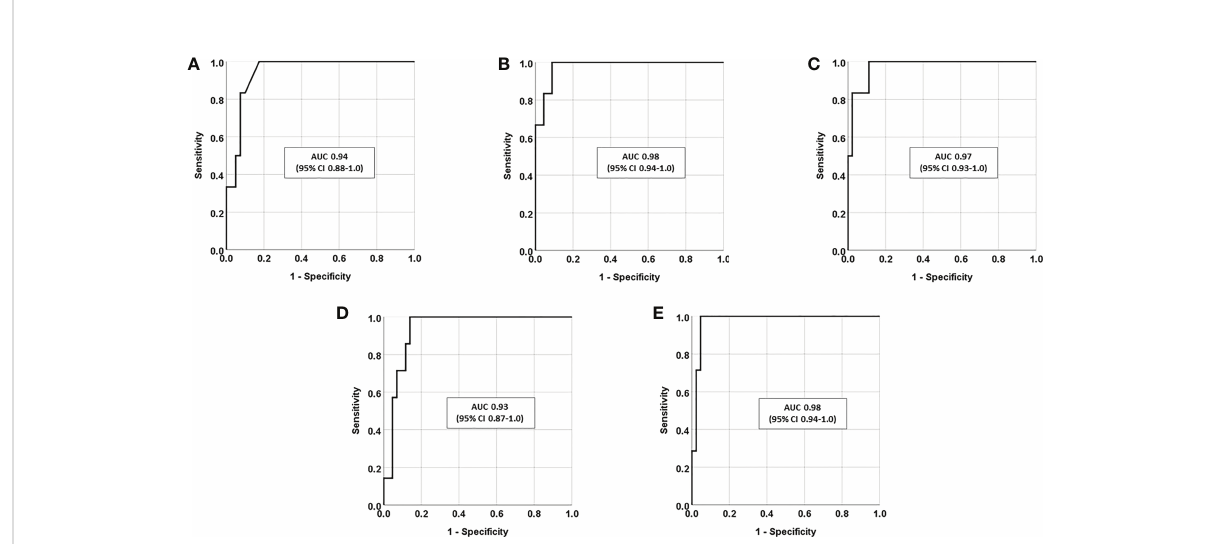
FIGURE 3 Receiver-operating characteristic (ROC) curves presented as area under the curve (AUC) together with 95% con fi dence intervals (95% CI), in patients with suspected Cushing ’ s syndrome (n=54) for (A) P-cortisol following dexamethasone suppression test (DST), (B) late-night Sa-cortisol (LNSC), (C) late-night Sa-cortisone, (D) Sa-cortisol at 8 a.m. following DST, and (E) Sa-cortisone at 8 a.m. following DST.